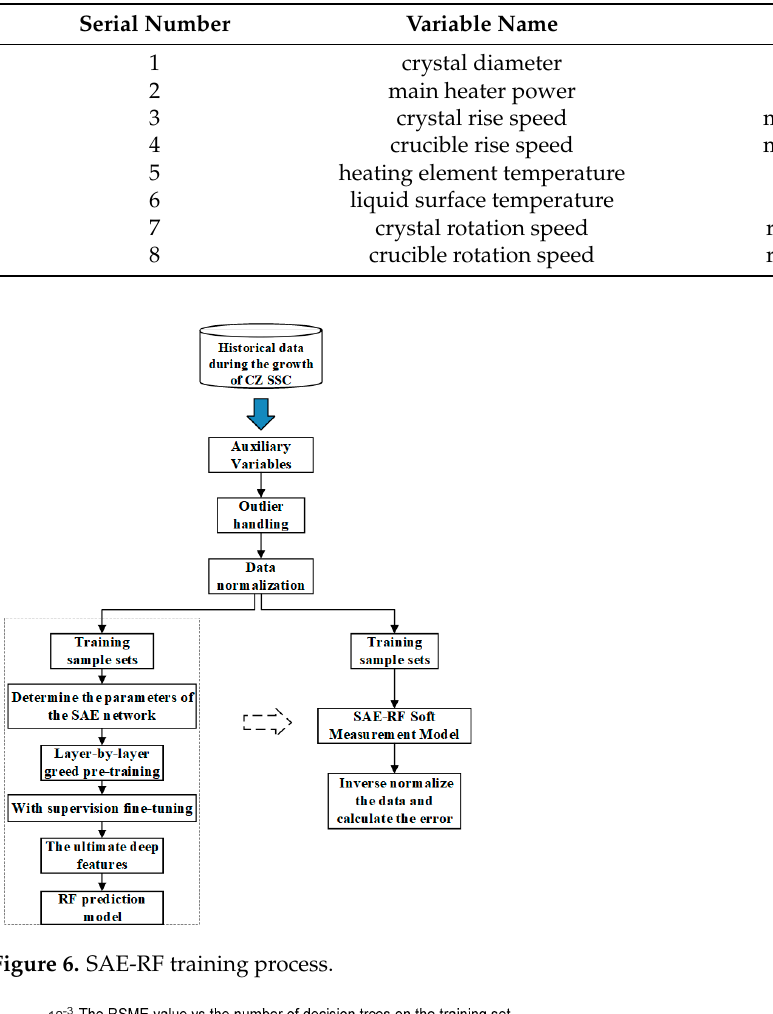
Table 1. Auxiliary variable.